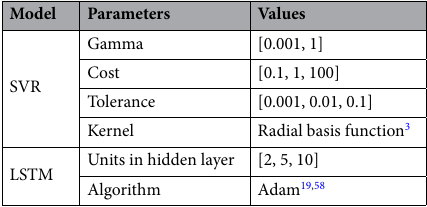
Table 2. Values of the parameters of the SVR and LSTM